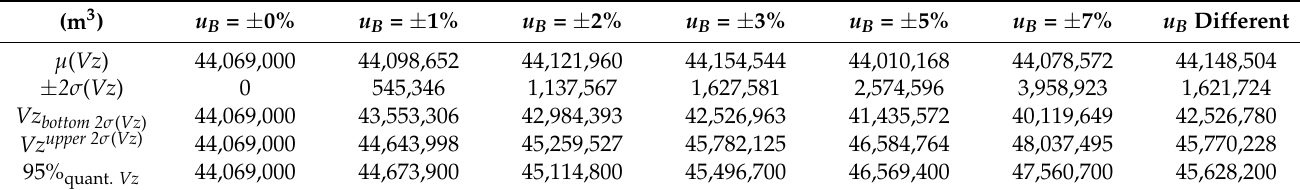
Table 3. Results of the analysis of optimal storage volumes V Z of the tested